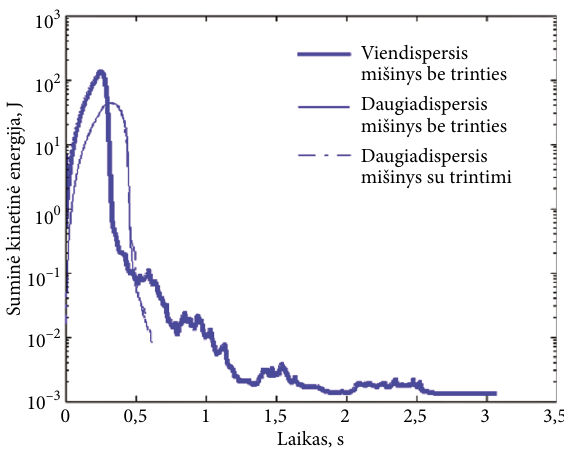
V ien d ispersis mi š in y s b e